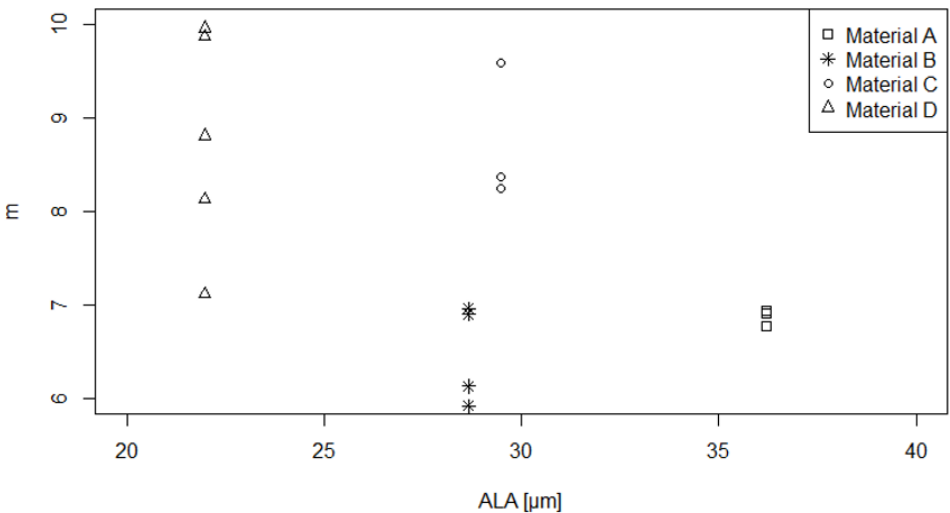
Figure 13. No clear correlation is observed between the microstructural parameter ALA and fatigue crack growth kinetics parameter